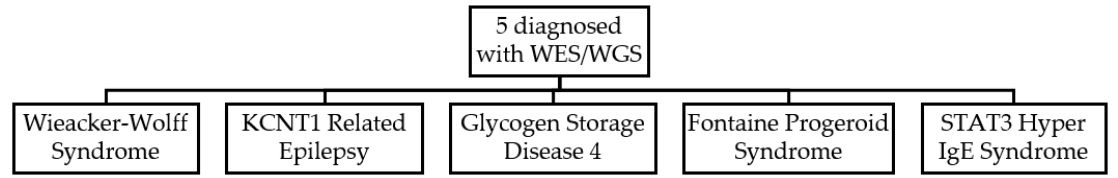
Figure 3. None of the conditions that were diagnosed by WES/WGS are on the RUSP.